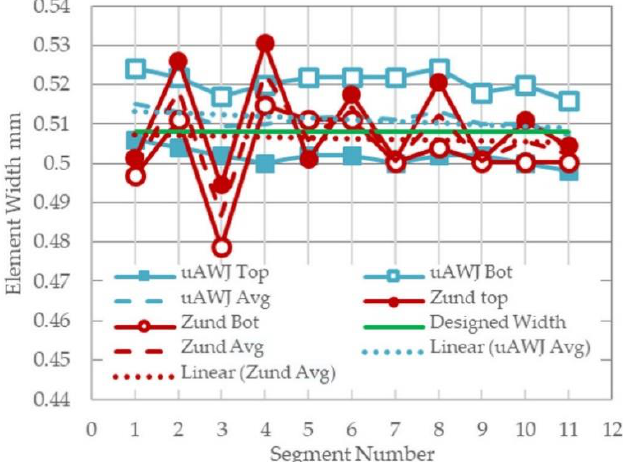
Figure 24.  AWJ-cut stack of stainless-steel flexure supported by aramid honeycomb. Figure 24. µ AWJ-cut stack of stainless-steel flexure supported by aramid honeycomb.